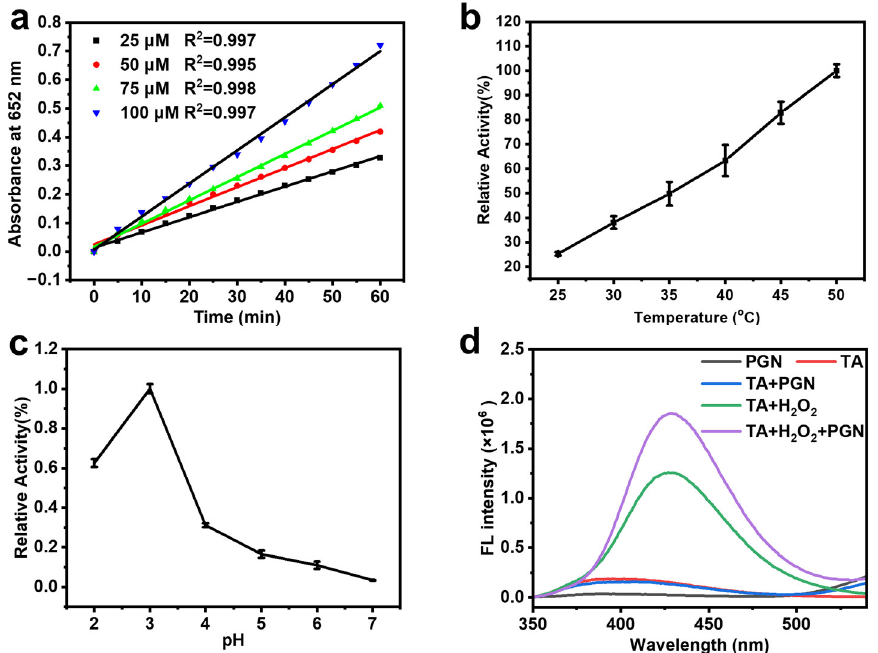
Figure 3. ( a ) Time-dependent absorbance change at 652 nm of mixture containing 100 mM H 2 O 2 and 5 mM TMB in the presence of different concentrations of the PGN (Au basis). ( b ) Temperature-dependent peroxidase-like activity of the PGN. ( c ) pH-dependent peroxidase-like activity of PGN. ( d ) Fluorescence spectroscopy monitoring of the oxidation of terephthalic acid to 2-hydroxyterephthalic acid in the presence of the PGN.